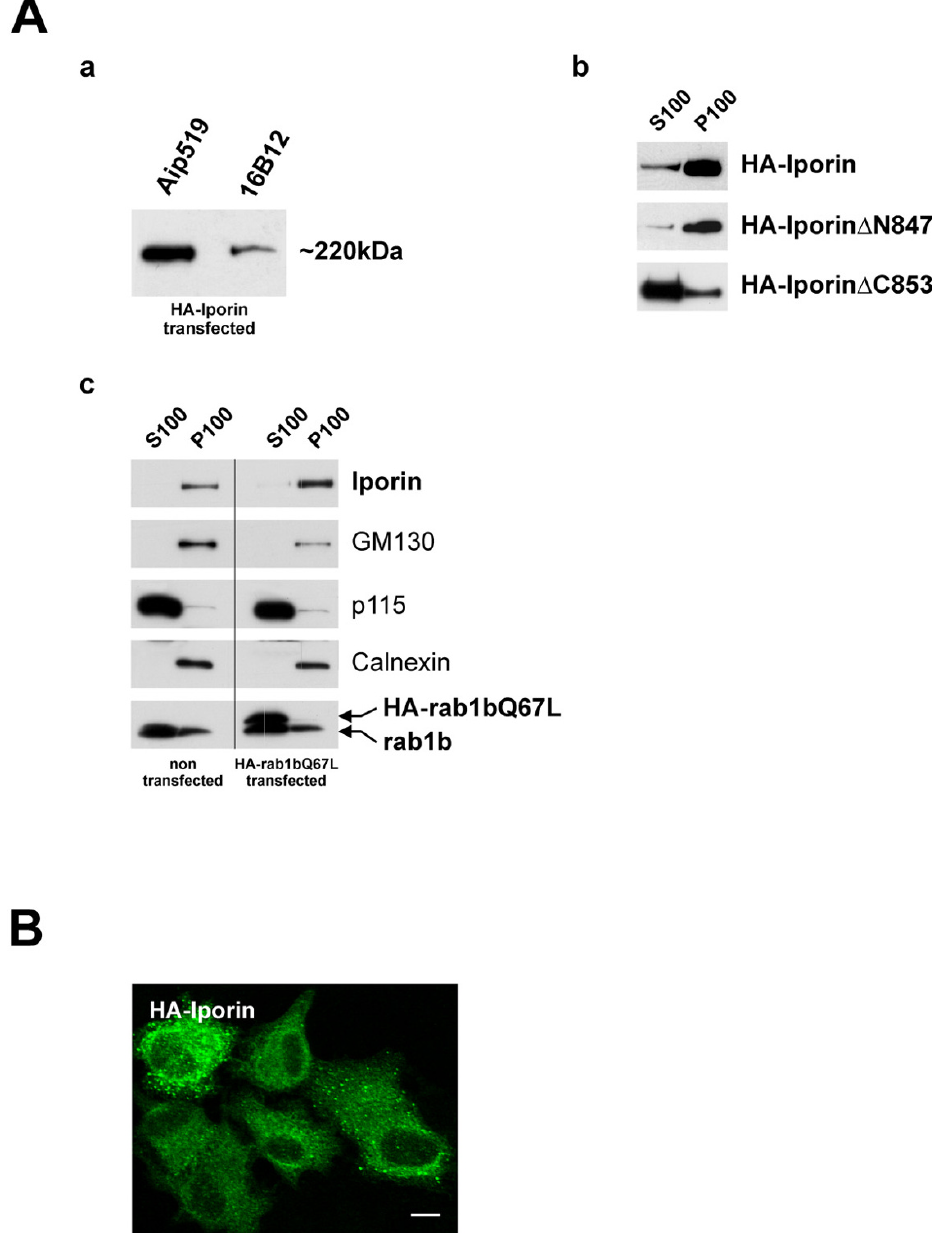
Figure 5 Cellular distribution of Iporin. (Aa) To test specificity of the polyclonal anti Iporin antibody Aip519, HeLa cells were tran- siently transfected with HA-tagged Iporin. After lysis, cell extracts were blotted and incubated with the Aip519 and the mono- clonal 16B12 anti HA antibody, respectively. The Western blot displays a signal of about 220 kDa for both antibodies. (Ab) Cytosol/membrane fractionation with extracts from transiently transfected HeLa cells. Recombinant HA-Iporin was detected with anti HA (16B12) antibody. Fractionation of full-length HA-Iporin and HA-Iporin ∆ N847 revealed that most of the recom- binant proteins were present in the membrane fraction (P100) with small amounts in the cytosolic (S100) fraction. In contrast, the transiently expressed HA-Iporin ∆ C853 was present in a high concentration in the cytosolic (S100) fraction. (Ac) Compar- ison between untransfected and HA-rab1bQ67L transfected HeLa cells. Blots were analyzed using the Aip519 (Iporin), anti- GM130 (GM130), anti-p115 (p115), anti-calnexin and 1E7 (anti-rab1b) antibodies. (B) Immunofluorescence staining of recom- binant HA-Iporin expressed in HeLa cells shows a cytosolic distribution with a perinuclear enrichment in spotted structures. Bar 10 µ